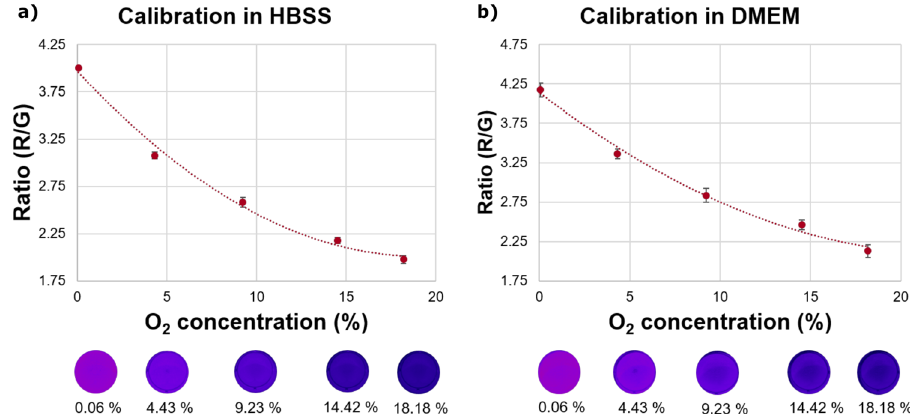
Fig. 1 Calibration curves for O 2 -sensitive nanoparticles. The calibration curves are obtained from plotting the ratio of the red and green channels obtained from luminescence images of O 2 -sensitive nanoparticles in HBSS ( a ) and DMEM ( b ). The colour-coded images at the bottom of the graph show the ratio images (red/green channel) in respective solutions. The mean ratio and standard deviation were obtained from the entire area of the coverslip. The dotted lines represent the curve fi t of a quadratic polynomial function ( r 2 > 0.99).